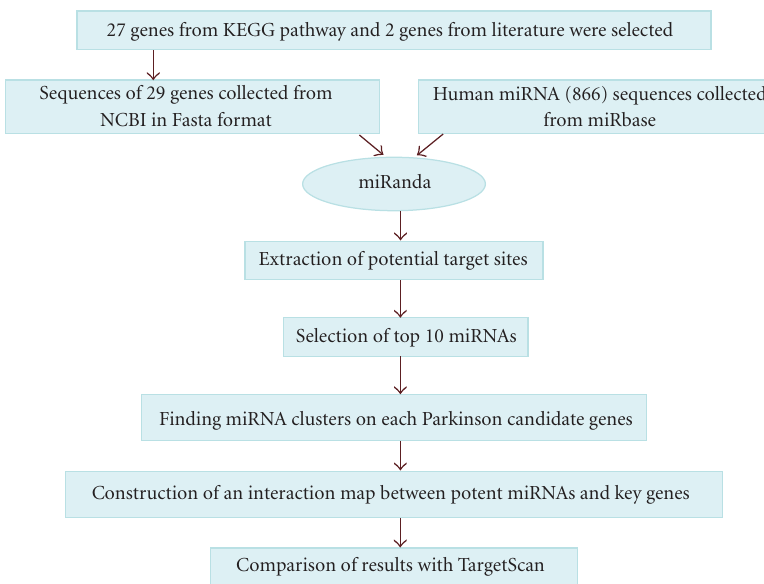
Figure 1: Schematic representation of the